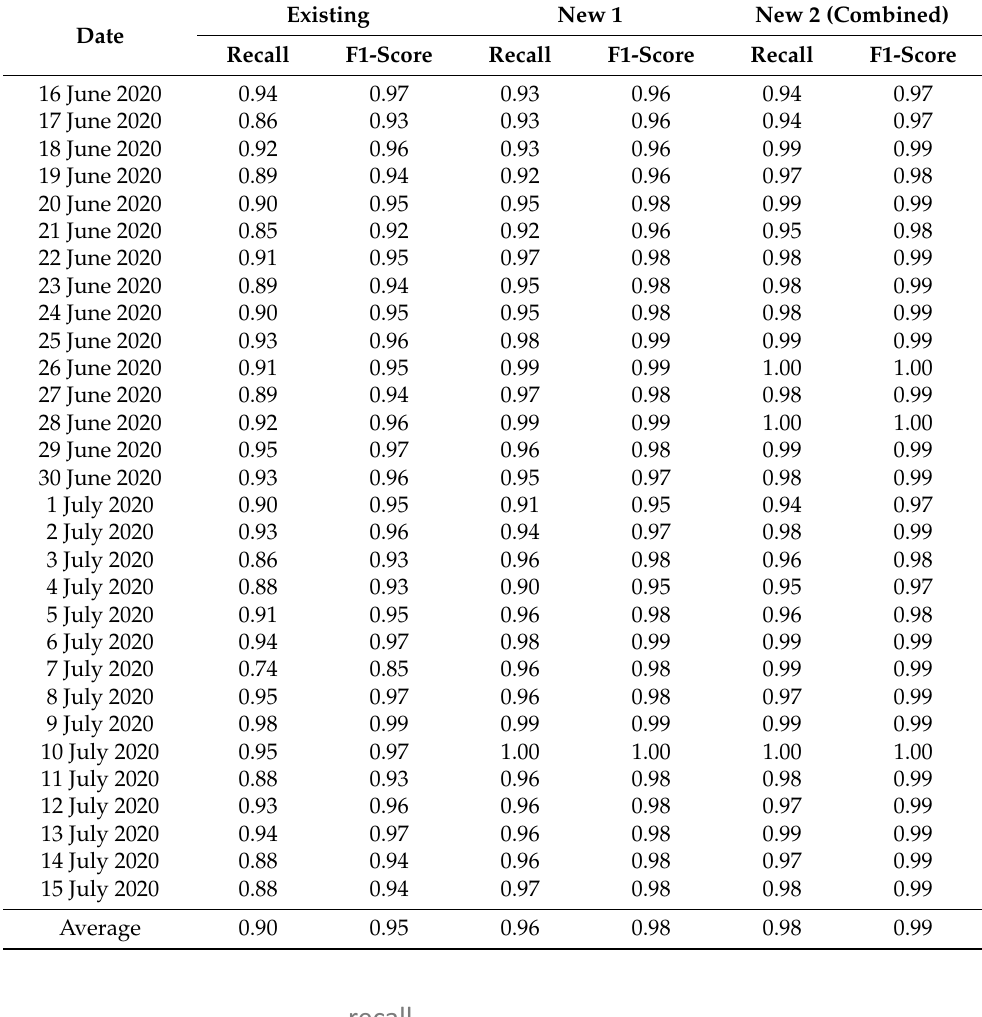
Table 6. Performance evaluation results.